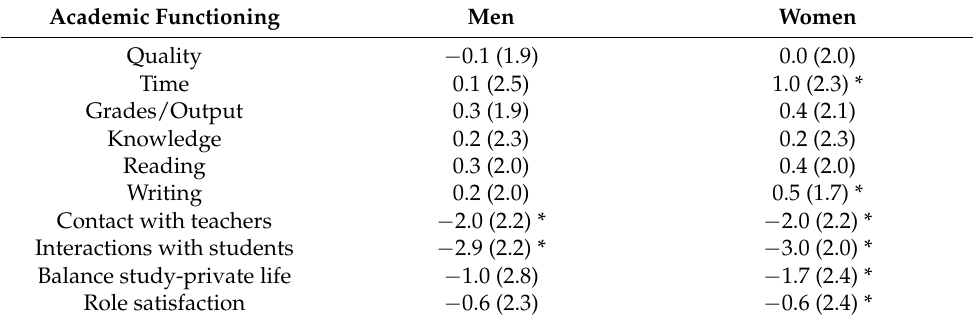
Table 3. Academic functioning during the COVID-19 pandemic according to sex.